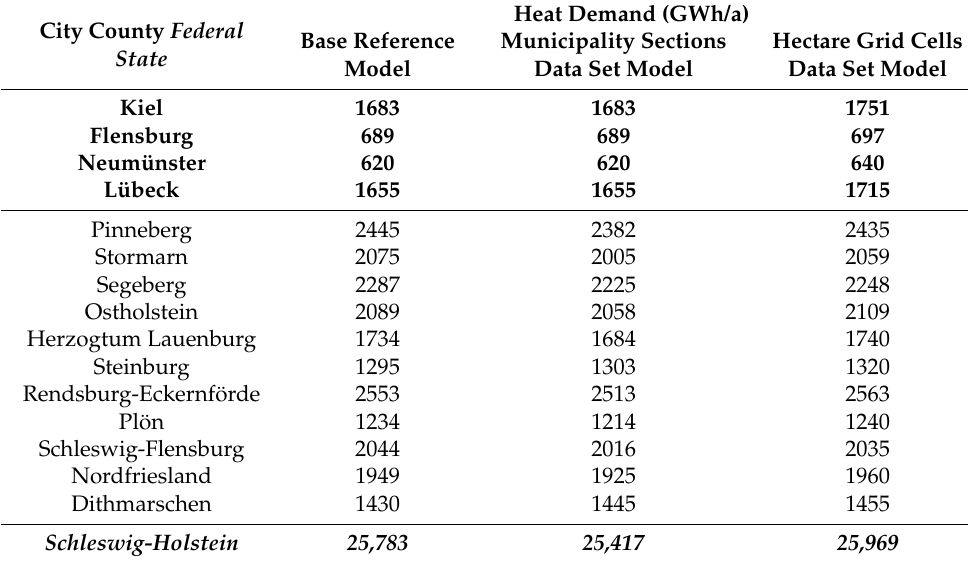
Table 2. Annual residential building heat demand per city and county in the study region for the base reference model without any information on building age and for the two models enhanced by spatial data sets on the construction period of residential